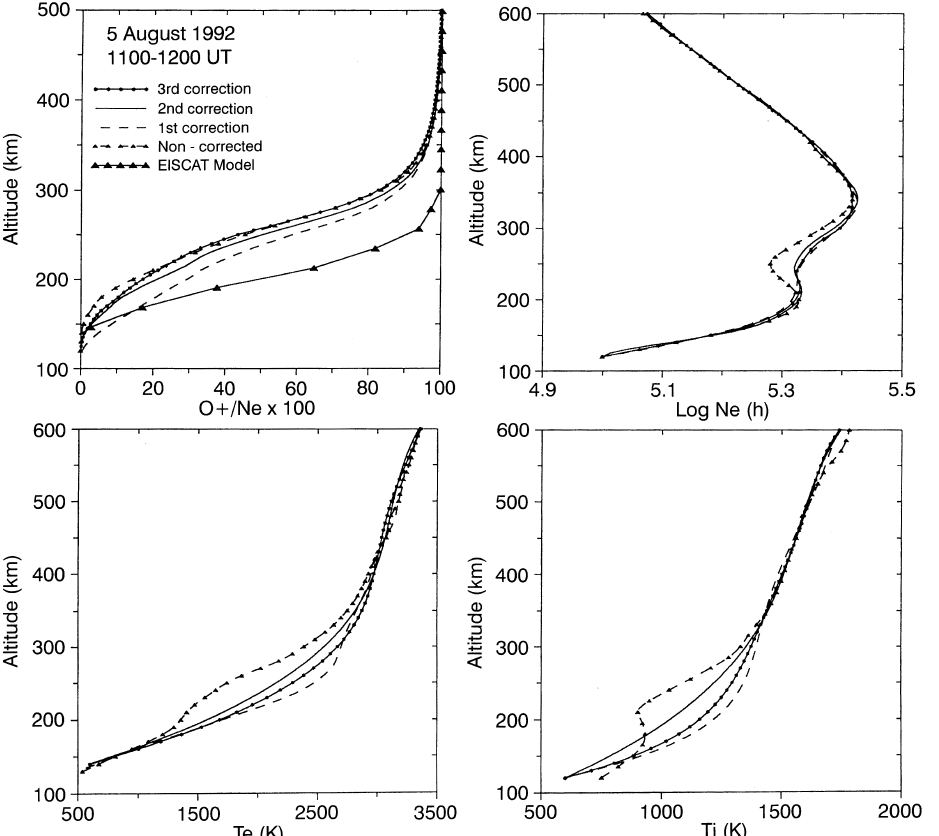
Fig. 2. The EISCAT ion-compo- sition model and three consecutive iterations using the calculated ion composition for the disturbed day of 5 August 1992. Routinely measured (‘non-corrected’) N e (cid:133) h (cid:134) , T e (cid:133) h (cid:134) and T i (cid:133) h (cid:134) profiles are also shown